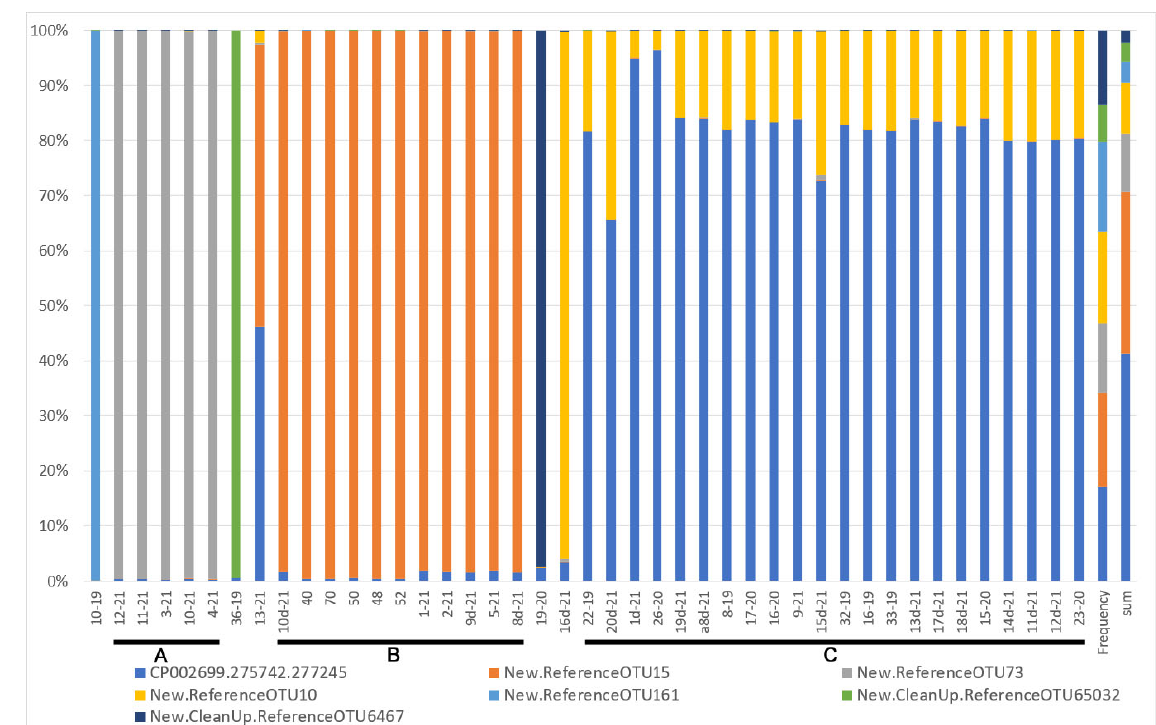
Figure 5. Shares of the 7 most abundant OTUs of Buchnera aphidicola in the studied samples. The order of samples follows the order of samples on the x-axis of the heatmap shown in Figure 4 (bars and letters indicate the same clades as those in Figure 4).